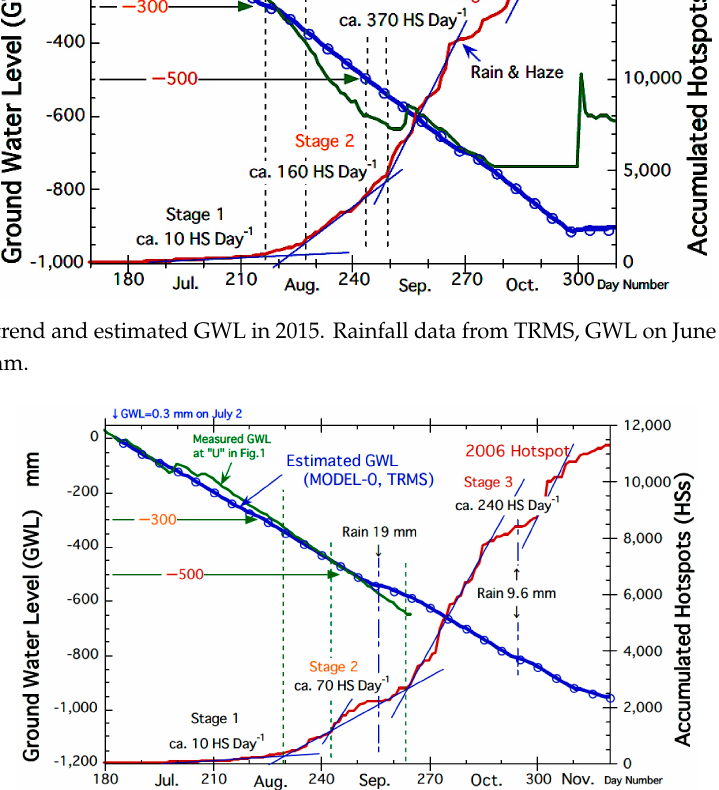
Figure 10. Fire trend and estimated GWL in 2006. Rainfall data from TRMS, GWL on July 2 (DN = 183) were set to 0 mm. GWL data measured at ‘U’ (2.32 S, 113.9 E) in Figure 1.